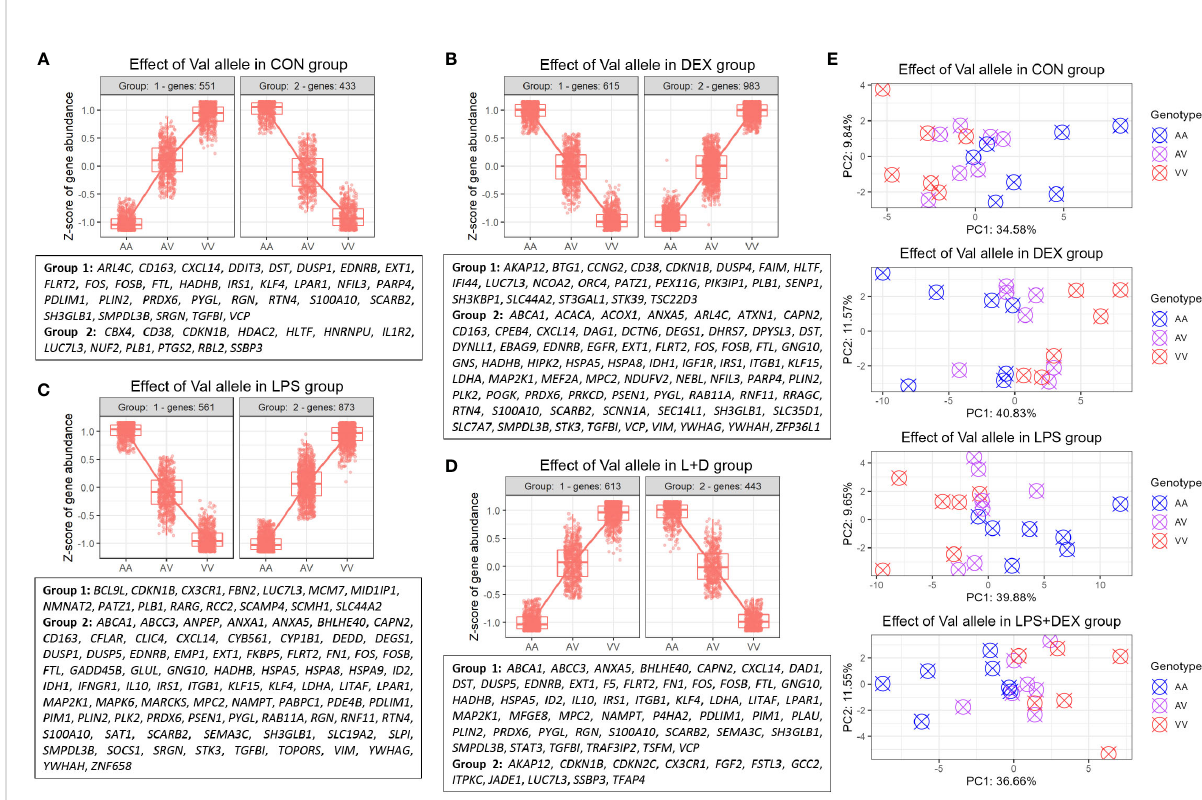
FIGURE 2 Identi fi cation of DEGs regulated by the Val allele additively (Val-up and Val-down genes). (A-D) Hierarchical clustering of expression pro fi les of Val-regulated DEGs in (A) CON, (B) DEX, (C) LPS, and (D) LPS+DEX groups. Previously reported glucocorticoid receptor (GR) targets identi fi ed through the database of Harmonizome (26) and Ingenuity Pathway Analysis (IPA) were displayed for each cluster. (E) Principal component analysis (PCA) of expression pro fi les of Val-up and Val-down genes in each treatment group. AA, GR genotype AlaAla; AV, GR genotype AlaVal; VV, GR genotype